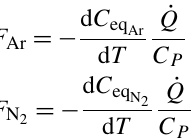
used in Fig. 2 and globally averaged surface temperature anomalies (Japan Meteorological Agency,